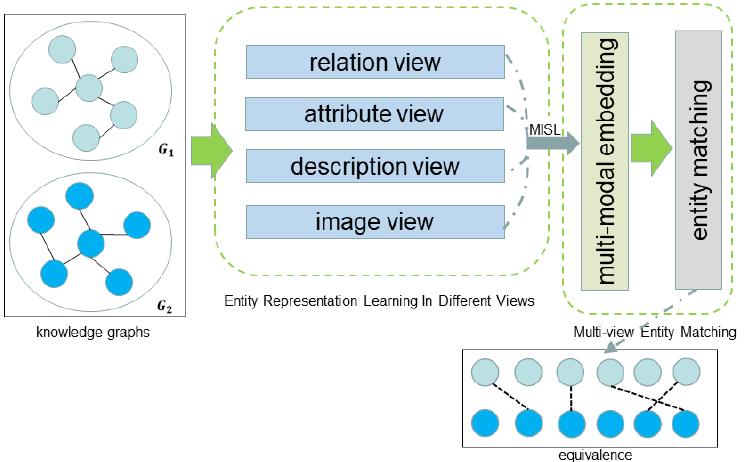
Figure 1. The framework of entity matching. G 1 and G 2 denote different knowledge graphs, MISL means multi-view intact space learning, and we use MISL to integrate entity information from different